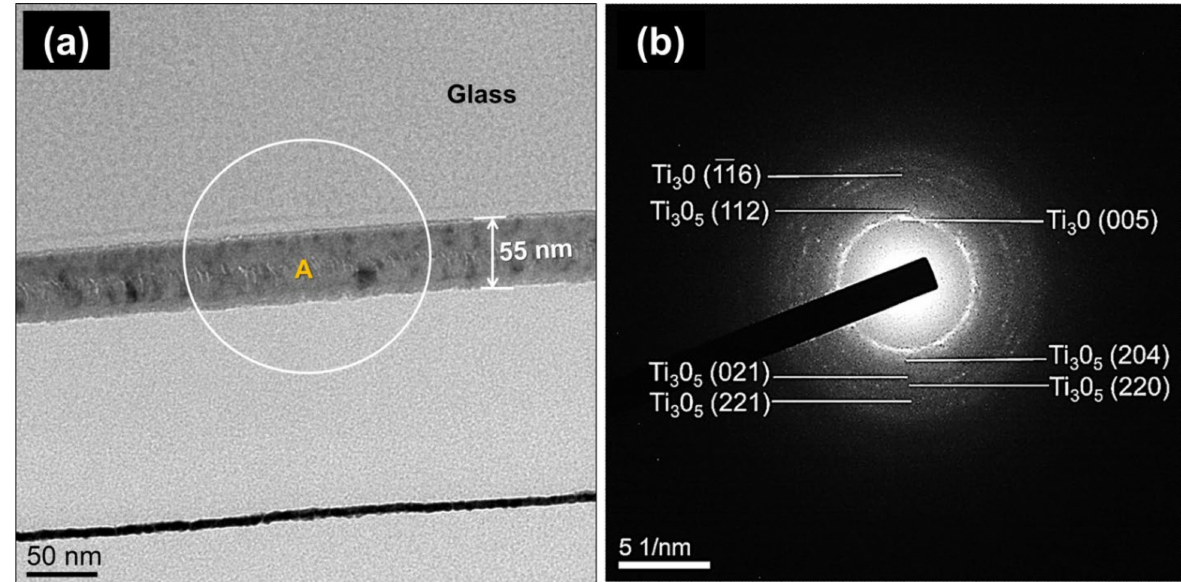
Figure 2. Cross-sectional HR-TEM images of Ti 3 O x thin-film sample deposit at 2 kW, ( a ) bright-field of the film with a thickness 55 nm. The image (inset A) was selected for electron diffraction analysis and ( b ) the selective area diffraction pattern of section “A” adjacent to Ti 3 O and Ti 3 O 5 .